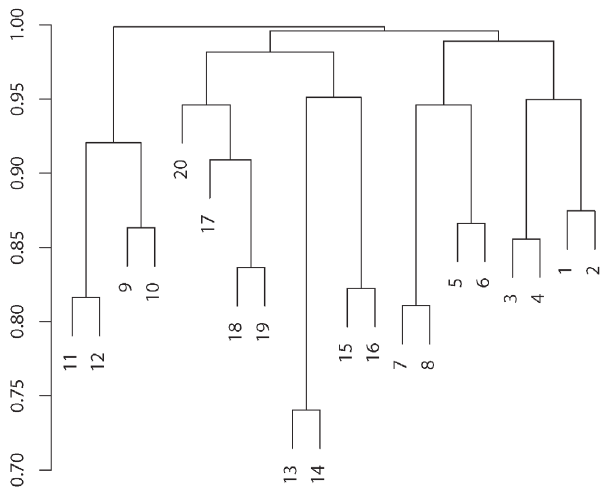
Figure 6. Hierarchical clustering: a dendrogram view showing hierarchical clustering of the genome data generated in the simulation based on the average-linkage method. The resulting grouping recovers the correlation structure in the simulation and leads to the optimal blocking scheme.